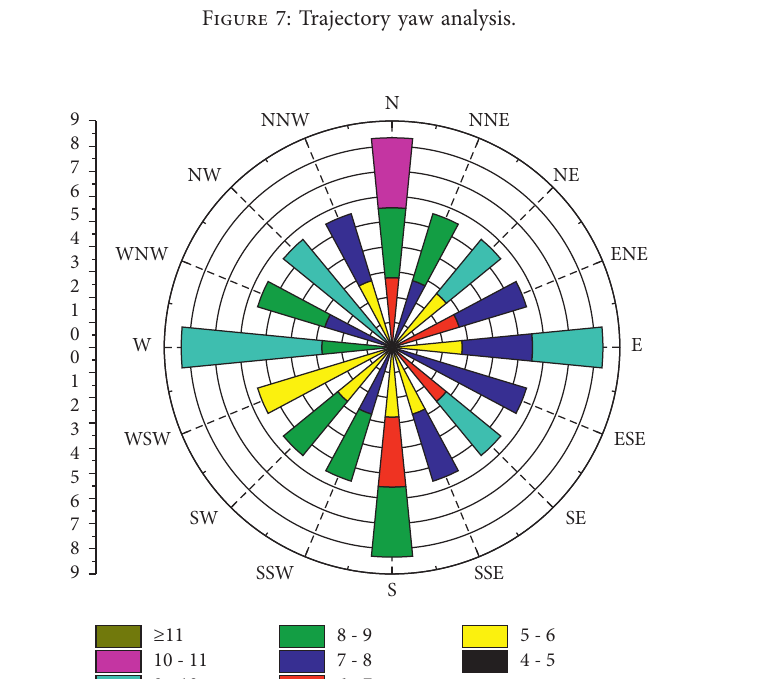
Figure 7: Trajectory yaw analysis.